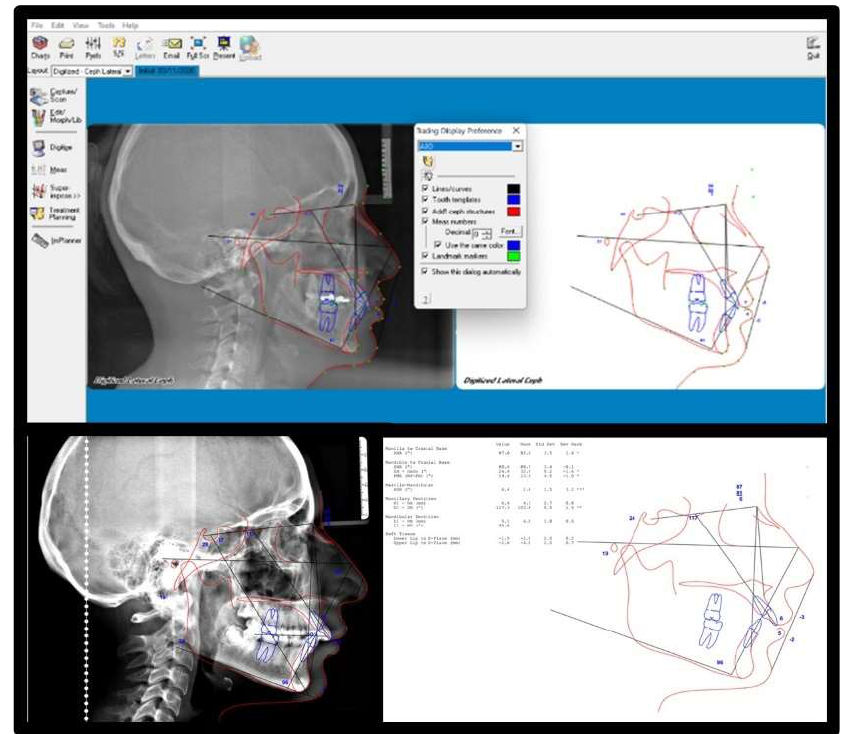
Figure 2. Digital tracing with the Dolphin Imaging Software 9.0.